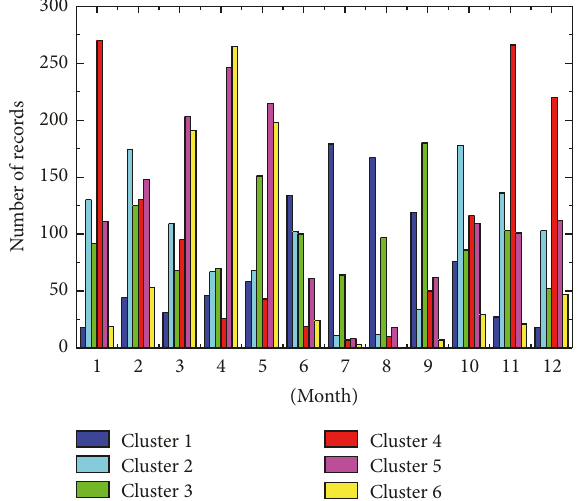
Figure 14: The monthly distributions for six clusters (2001–2014).